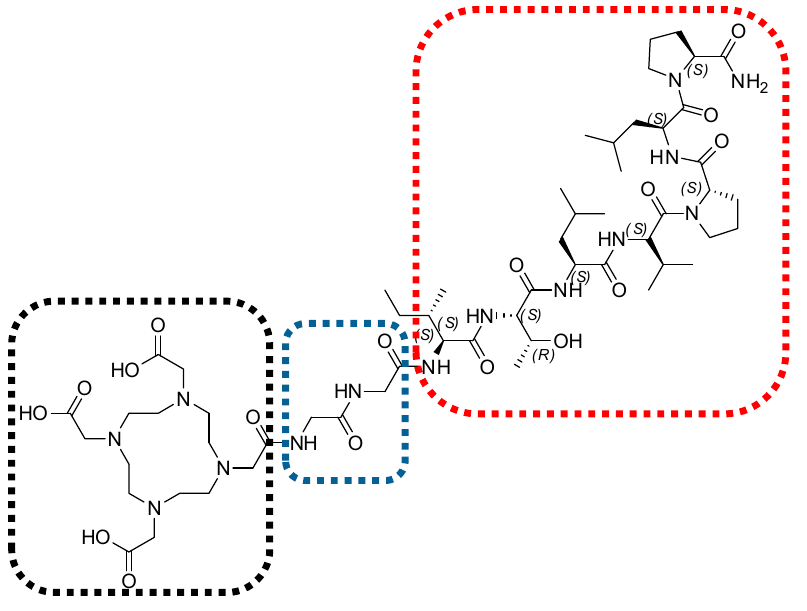
Figure 2. Chemical structure of DOTA-TBIA101. The depsipeptide NH 2 - L -Proline- L -Leucine- L - Proline- L -Valine- L -Leucine- L -Thronine- L -Isolleucine-OH (TBIA101, red-dotted area) is linked via bi- L -Glycine (blue-dotted area) with the bifunctional chelator molecule 1,4,7,10-tetraazacyclododecane- 1,4,7,10-tetraacetic acid (DOTA, black-dotted area).